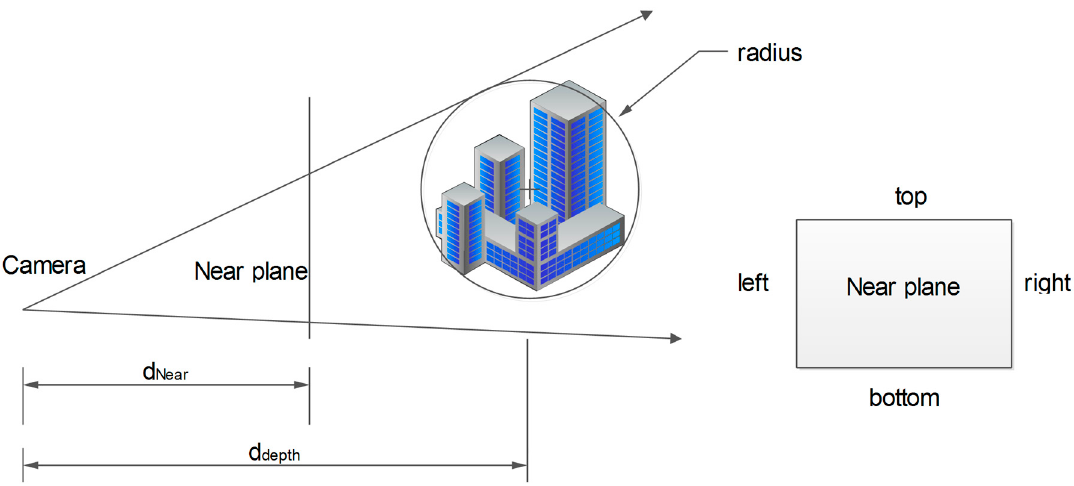
Figure 16. Level of detail (LOD) switch with pixel threshold.